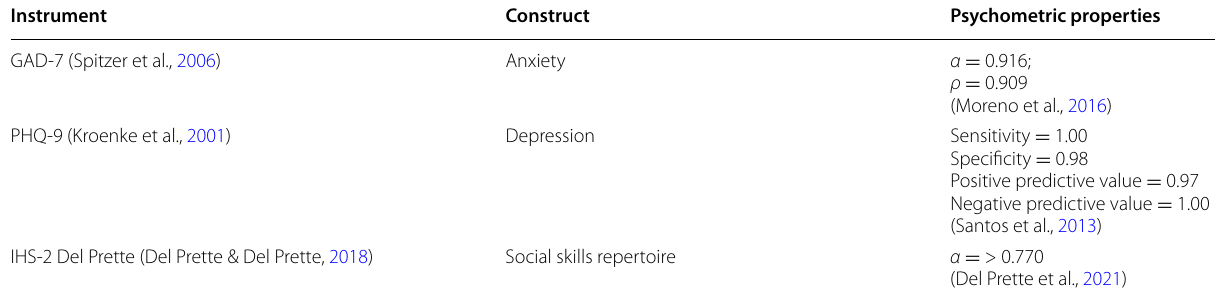
Table 1 Instruments’ information for GAD‑7, PHQ‑9, and IHS‑2 Del Prette Instrument